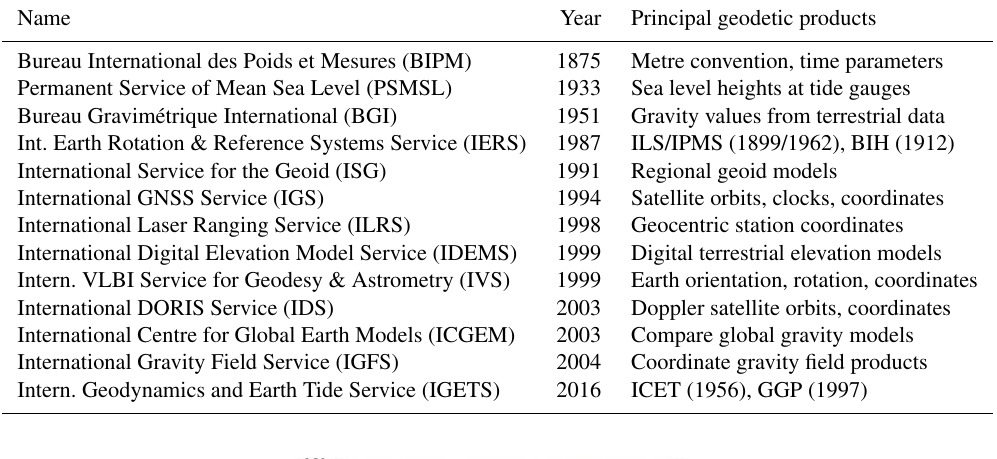
Table 2. IAG Scientific Services (Status 2018).